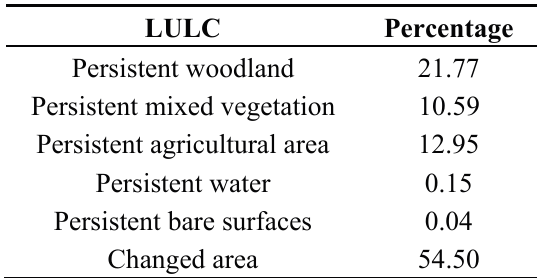
Table 2. Proportion of persistent land use/covers and changed area between 1999, 2006 and 2011.